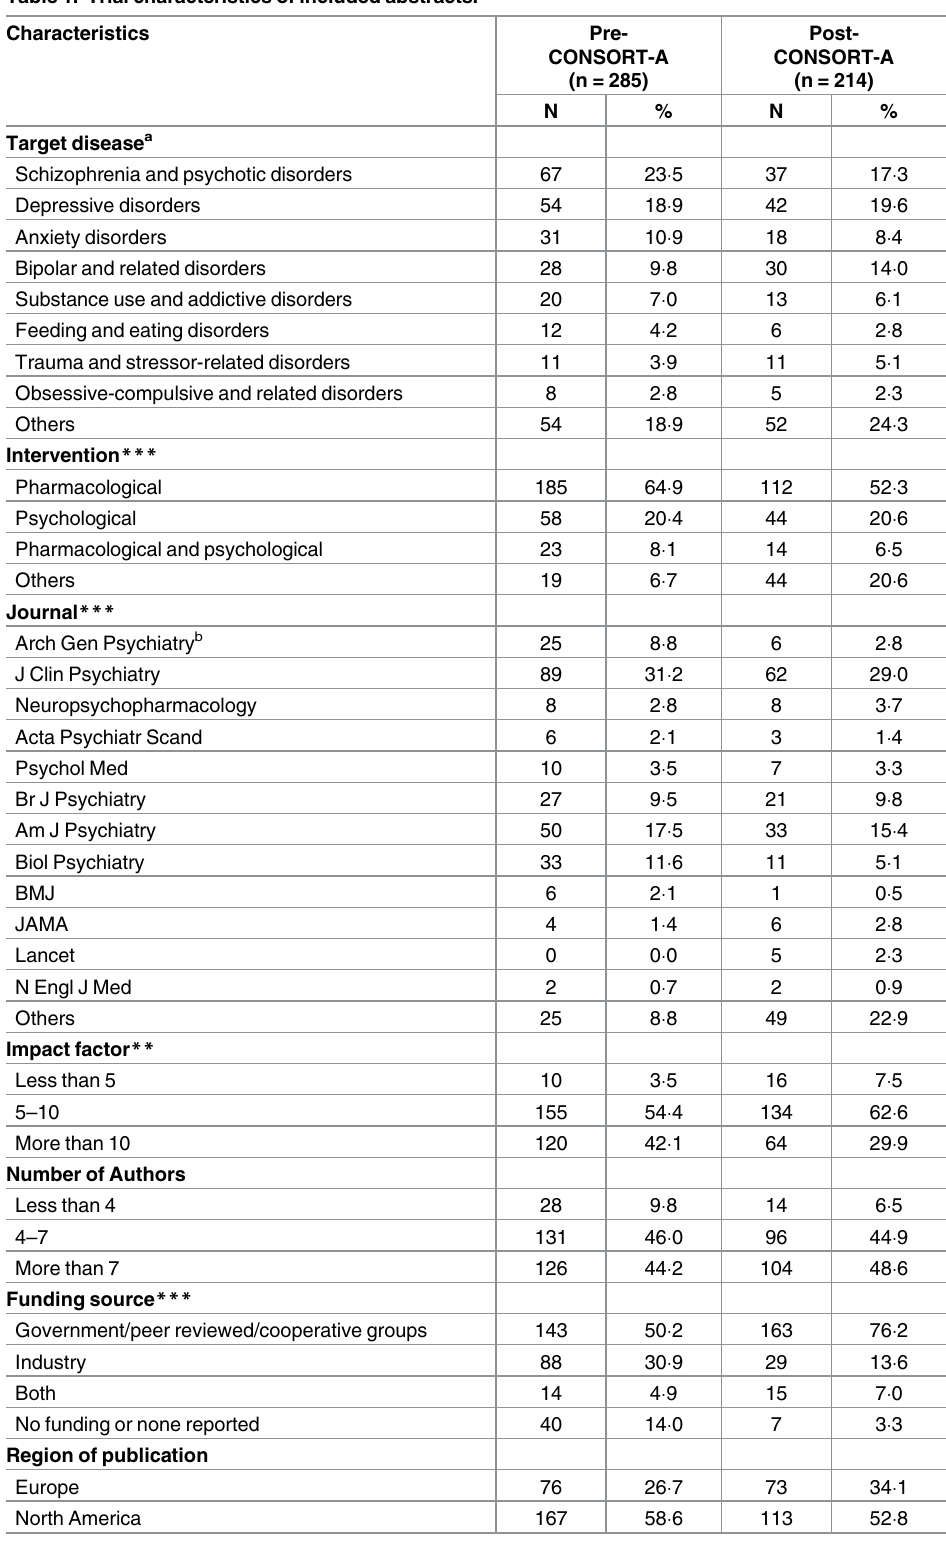
Table 1. Trial characteristics of included abstracts.